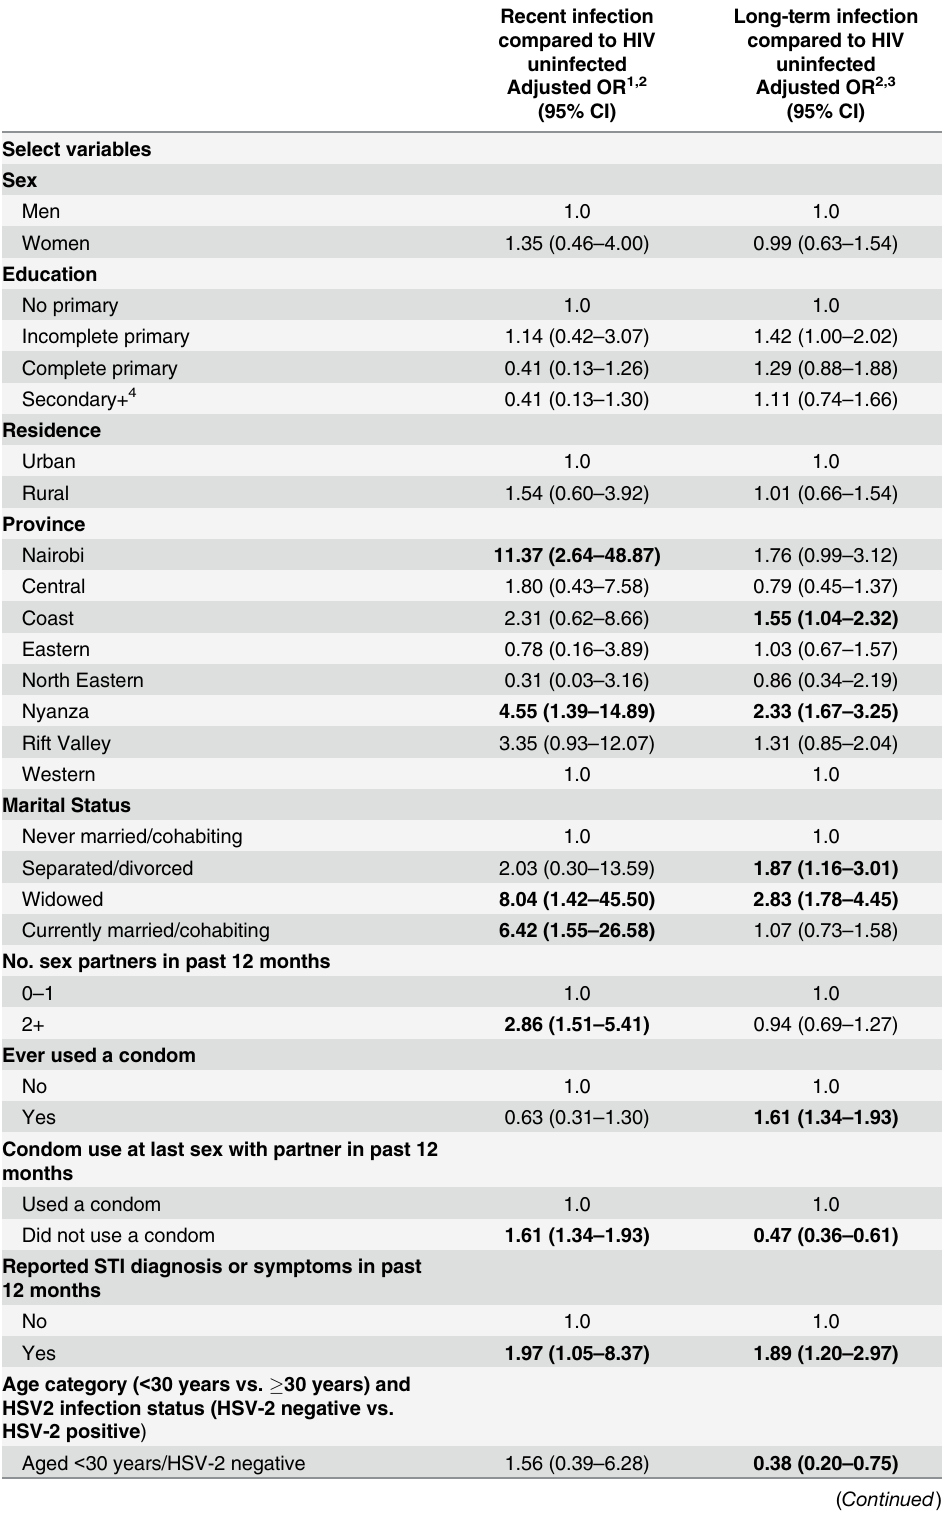
Table 3. Factors associated with recent and long-term infection among persons aged 15 – 64 years in Kenya, 2007 Kenya AIDS Indicator